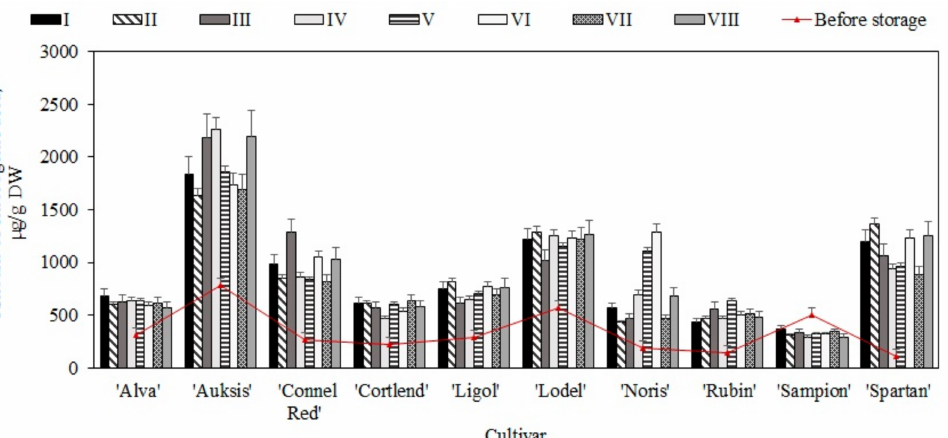
Figure 1. Changes in the amount of chlorogenic acid in whole apple samples before and after storage in controlled